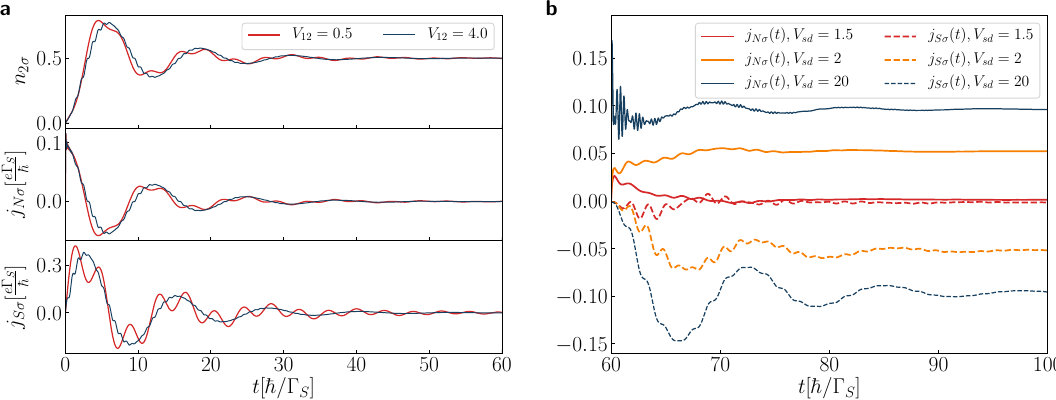
Figure 2. Transient and post-quench dynamics. ( a ) The time-dependent charge n 2 σ and transient currents j S σ , 0.5 , 4, assuming the initially empty quantum dots. ( b ) The post-quench currents j j N σ obtained for V 12 /Ŵ S = 2 after an abrupt biasing by the source-drain voltage V and j N σ for V 12 /Ŵ S = 0 , Ŵ 0 , ε 0.2 done for U i σ = N /Ŵ S = =